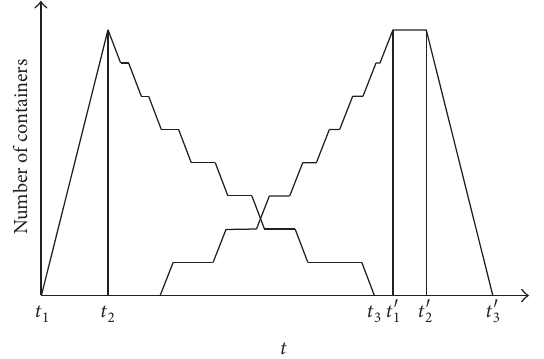
Figure 1: Number of containers for vessel at storage yard. 𝑡 1 : starting time of unloading containers from a certain vessel; 𝑡 2 : starting time of loading containers onto several trains; 𝑡 3 : ending time of loading containers onto several trains; 𝑡 󸀠 1 : ending time of unloading containers from several trains; 𝑡 󸀠 2 : starting time of loading containers onto a vessel; 𝑡 󸀠 3 : ending time of loading containers onto a vessel.